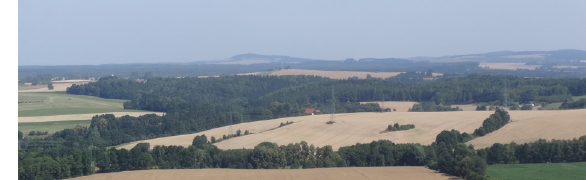
fig. 3a. Typical landscape of the surroundings of Stolpen (Germany). Dominant features of a “rural landscape”.